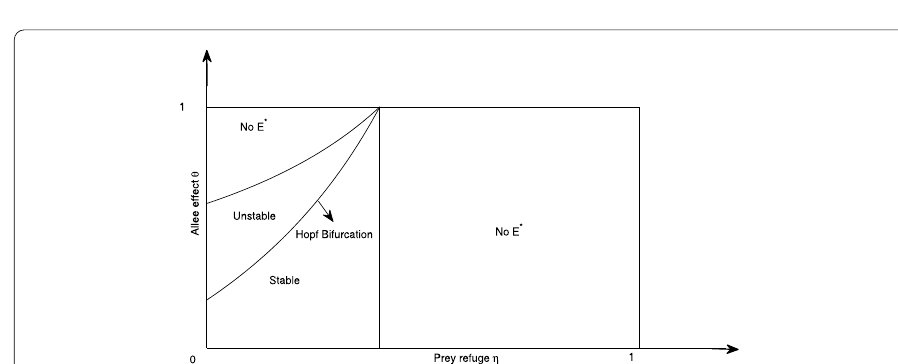
and ∂ P ∗ > 0 for all 1 – ∂η